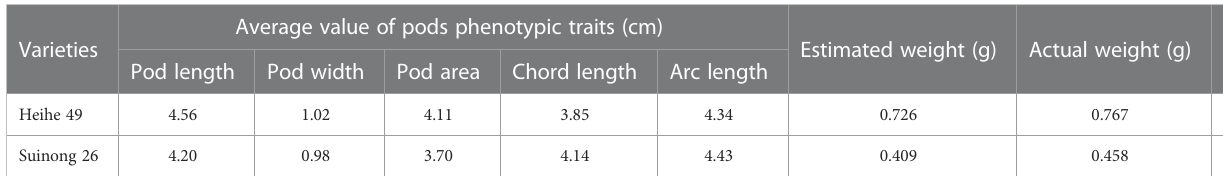
TABLE 4 Statistics of pods weight estimation model at maturity stage. Average value of pods phenotypic traits (cm) Varieties